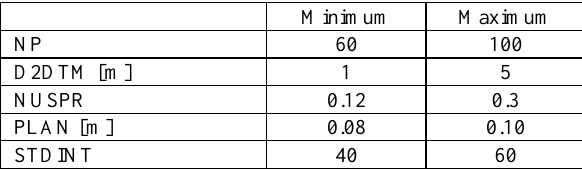
Table 2 Threshold values to meet conditions for our rule based classification of collapsed